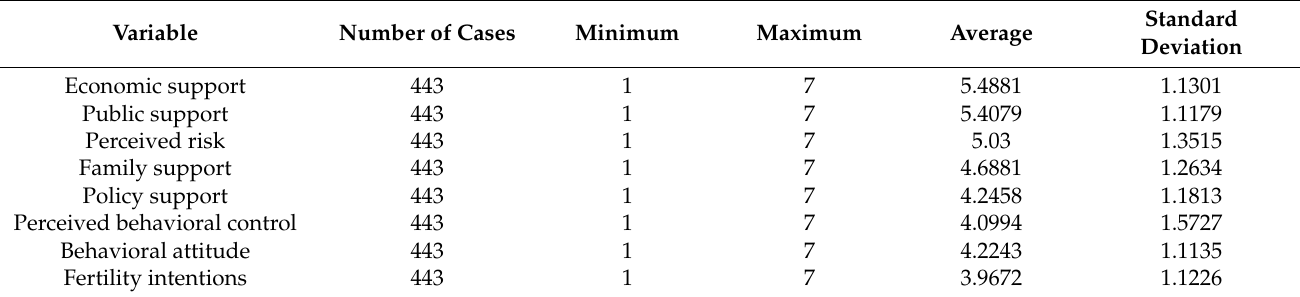
Table 8. Comprehensive score table for each